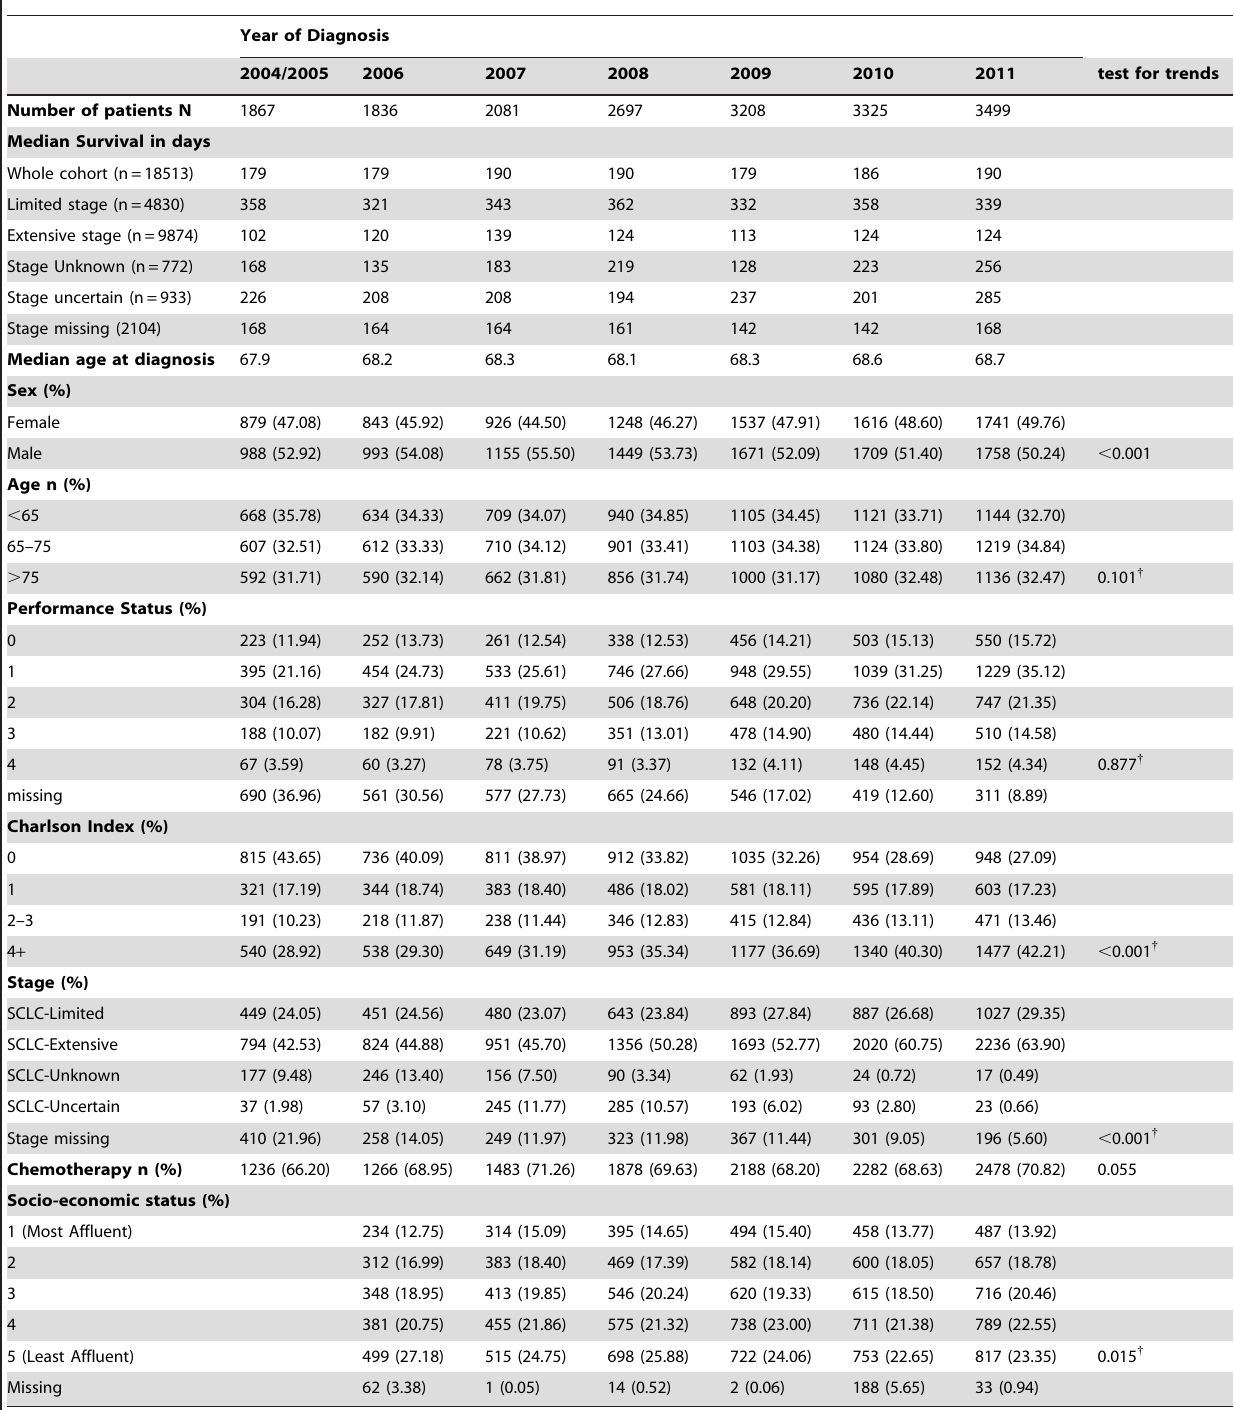
Table 1. Changing features of patients with small-cell lung cancer over the duration of the NLCA